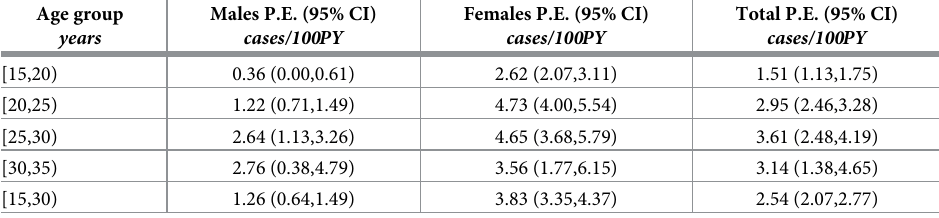
Table 3. ‘Average incidence’ estimates by age group using the combined method.